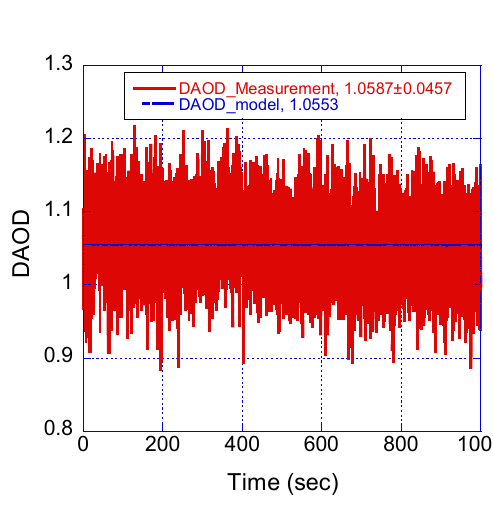
Fig. 2a. DAOD measurement by the IPDA lidar. The measurement is derived from a single shot return signal. It is compared to model predicted DAOD value.